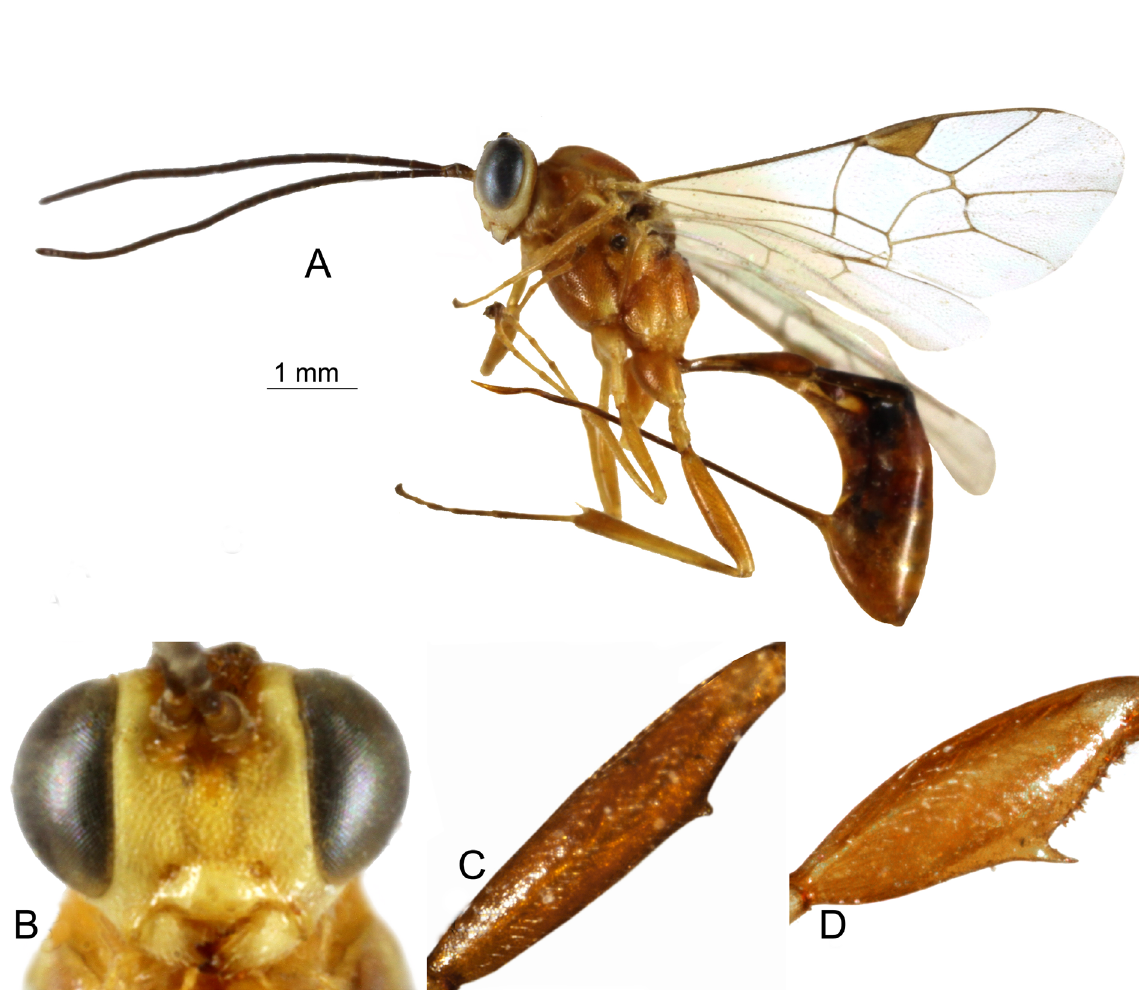
Fig. 5. Pristomerus cunctator Tosquinet 1896. A . ♀, habitus, profile. B . ♀, head, facial. C . ♀, hind femur, profile. D . ♂, hind femur,